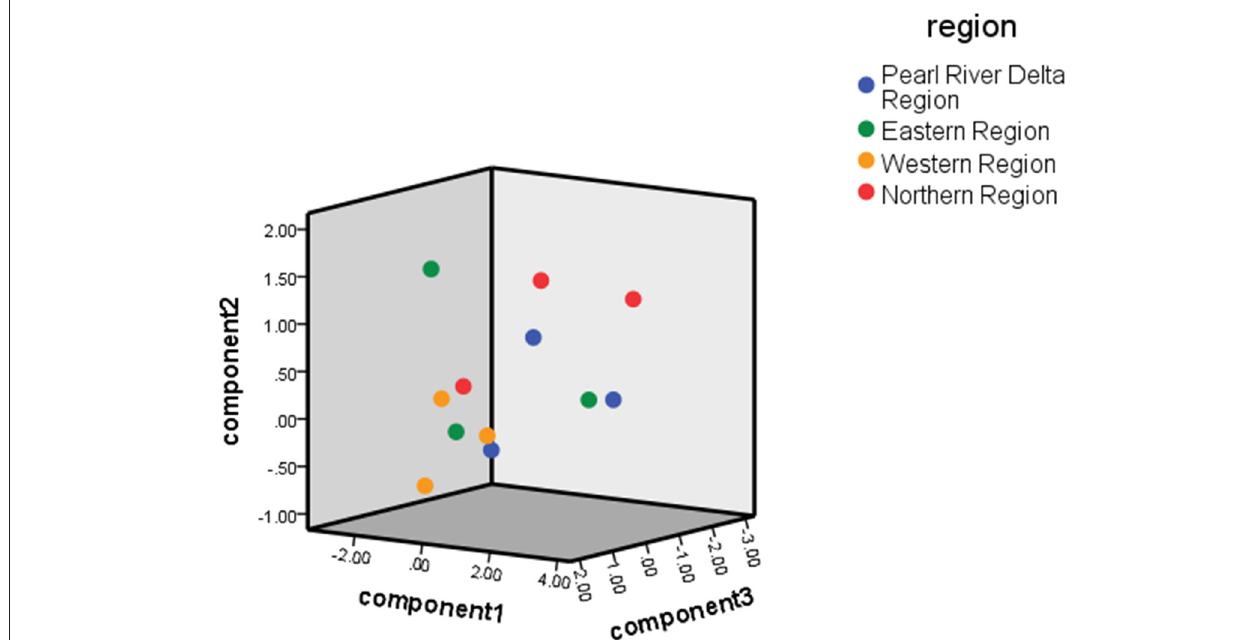
FIGURE 2 | General hospital.